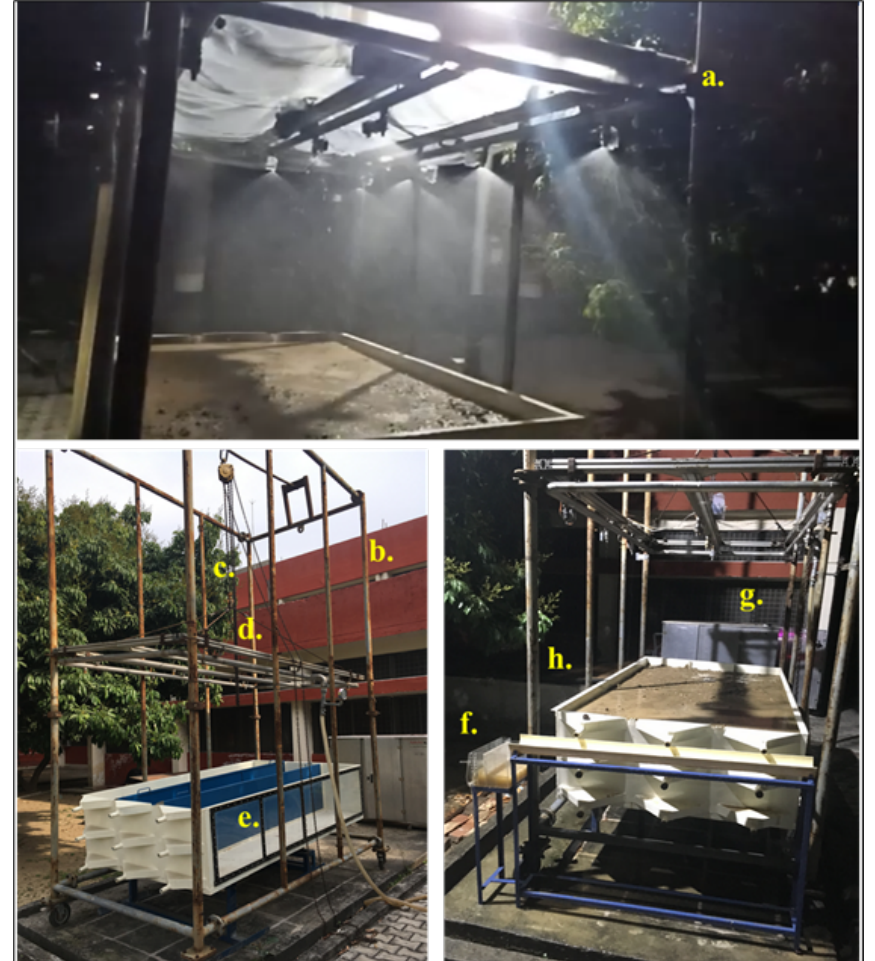
Figure 8. Designed rainfall simulator for moving storm